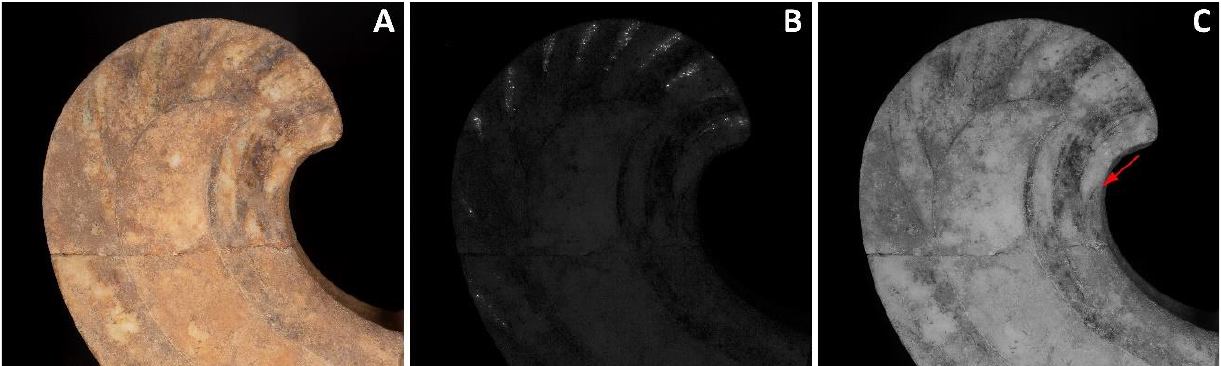
Figure 3. Imaging of the proper right wing of the sphinx: ( A ) VIS image showing traces of the original colors of the feathers; ( B ) VIL image illustrating the presence and distribution of the luminescence of Egyptian blue between the feathers; ( C ) IRR image highlighting the presence of black outlines defining the feathers, indicated by the red arrow.